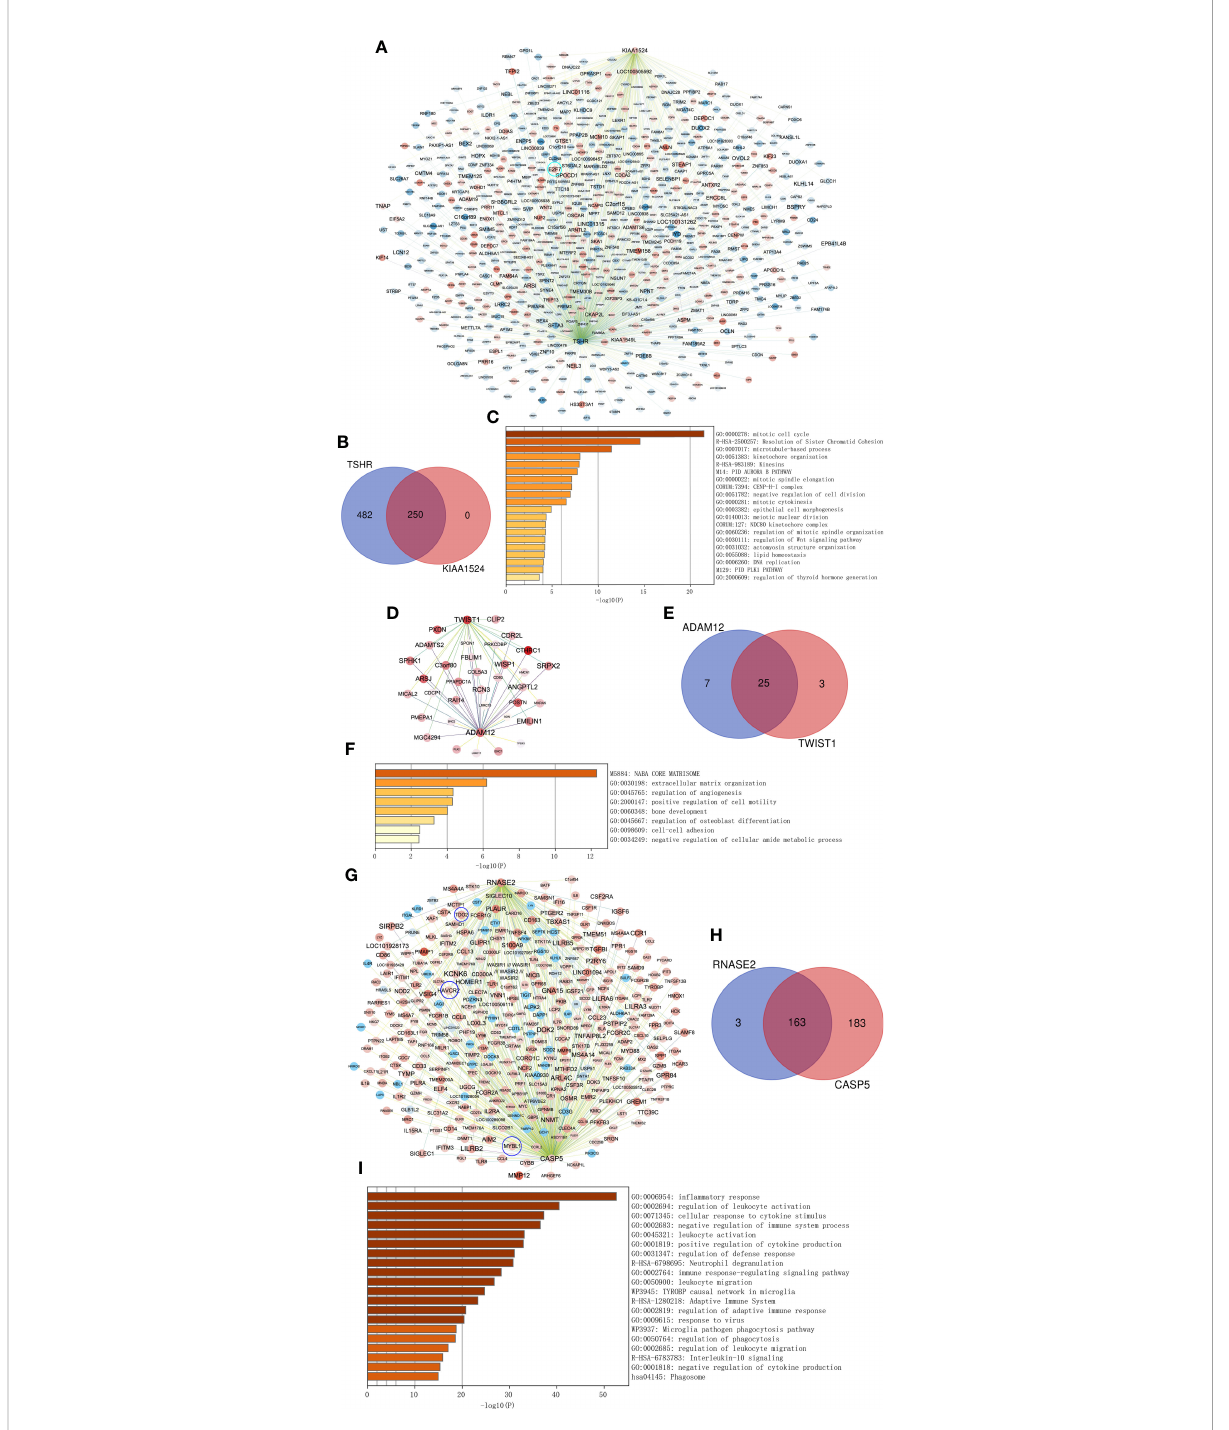
FIGURE 7 Co-expressed networks of two top genes and enrichment analysis. (A) Co-expressed hub genes of TSHR and KIAA1524 in the turquoise module. Each node represents a gene. The blue nodes denote lower expressed genes in ATC compared to normal thyroid samples, while the red nodes denote higher expressed genes. The darker the node, the more differentially expressed the gene between ATC and normal thyroid samples. The edges between nodes indicate co-expression between them. The darker the edges, the stronger the co-expression relationship. (B) Overlapping co-expressed genes of TSHR and KIAA1524 . (C) Top 20 Biological processes and pathways enriched by all co-expressed genes of TSHR and KIAA1524 . (D – F) The same as A-C, but in the magenta module and two key genes ADAM12 and TWIST1 in this module. (G – I) The same as A-C, but in the blue module and two key genes RNASE2 and CASP5 in this